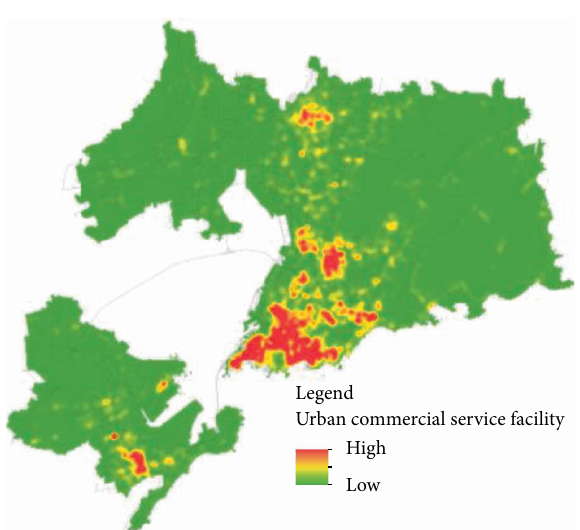
Figure 17: Distribution of public facilities.